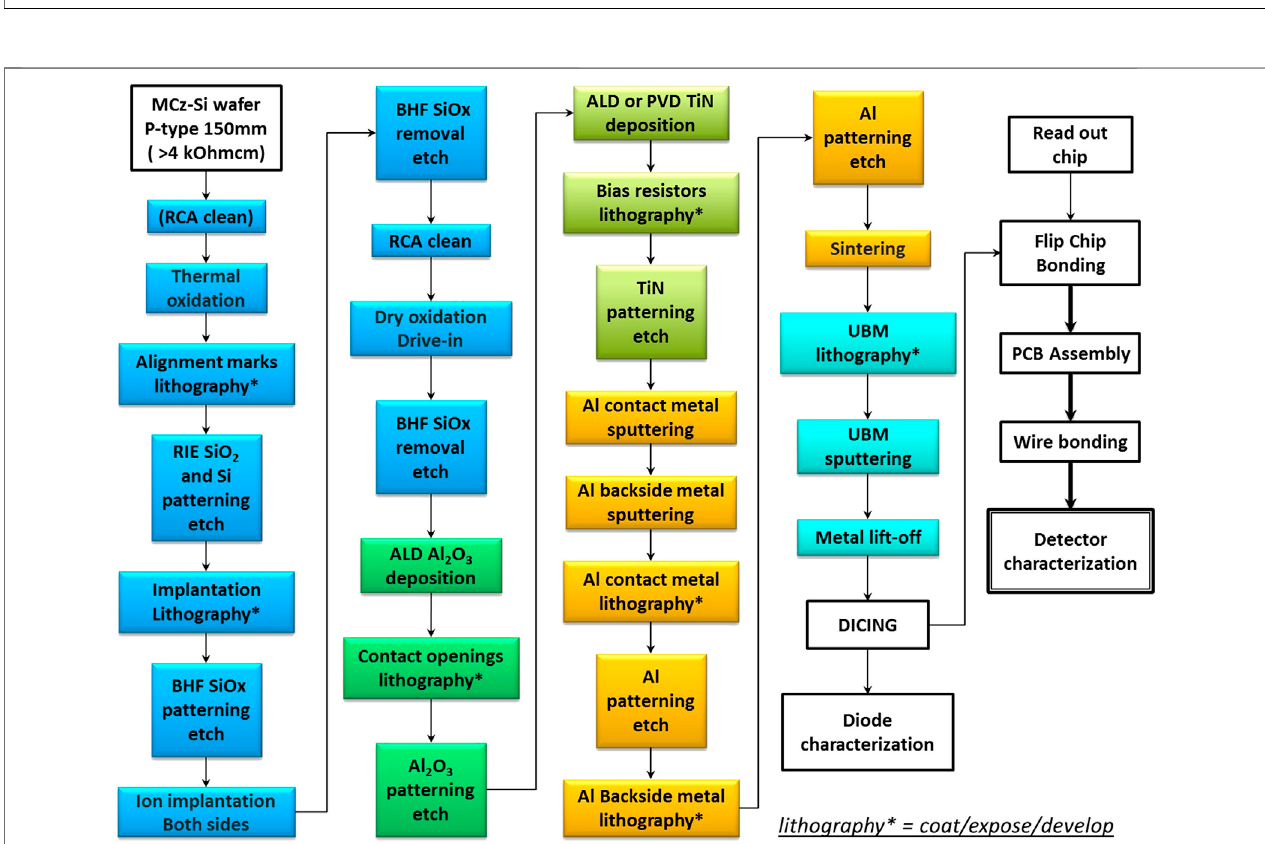
FIGURE 2 | Process fl ow for the manufacture of AC-coupled MCz silicon pixel detectors with ALD-grown thin fi lm.